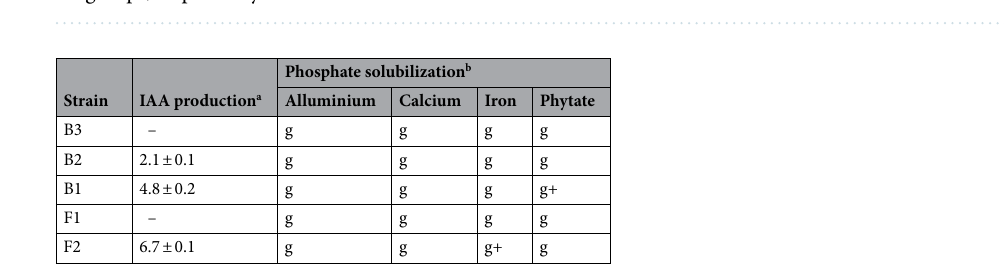
Figure 1. Bacterial ( A ) and fungal ( B ) phylogenetic tree based on sequences of 16S rRNA gene and of ITS1-2 region, respectively, derived from C. limon seed endophytes and sequences retrieved from the NCBI database according to BLAST interrogation for sequence homology. ( A ) B1–3: bacterial endophytes isolated from C. limon seeds. ( B ) F1–4: fungal strains isolated from C. limon seeds. The branching pattern was generated by NJ method and Nei’s distance. The species ( A ) and genera ( B ) analyzed were highlighted using colors reported in legends. Different clusters (a, b, c and d) and bootstrap values (1000 replicates) were indicated in the figure. The sequences of the Escherichia coli 16S rRNA gene ( A ) and Candida maltose ITS1-2 region ( B ) were used as outgroups, respectively.